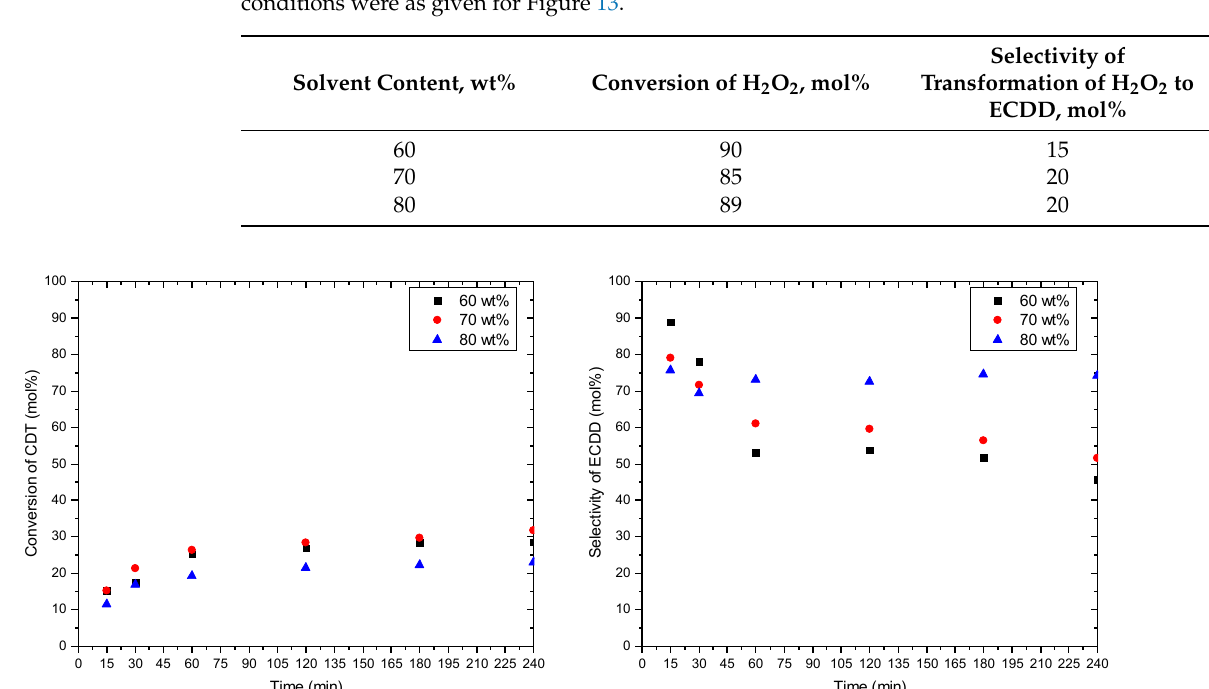
Figure 13. Conversion of CDT and selectivity of transformation of CDT to ECDD as a function of time for reactions performed with different solvent compositions. Reaction conditions: i-PrOH solvent; CDT:H 2 O 2 molar ratio, 1:1; catalyst, 5 wt%; temperature, 80 °C; mixing speed, 500 rpm. Table 3. Values of the conversion of H 2 O 2 and selectivity of transformation of H 2 O 2 to ECDD ob- tained after 4 h of performing the reaction with different i-PrOH solvent compositions. Reaction conditions were as given for Figure 13.